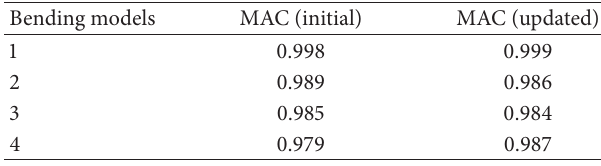
Table 4: Model updating variables (stiffness values) corresponding to the physical